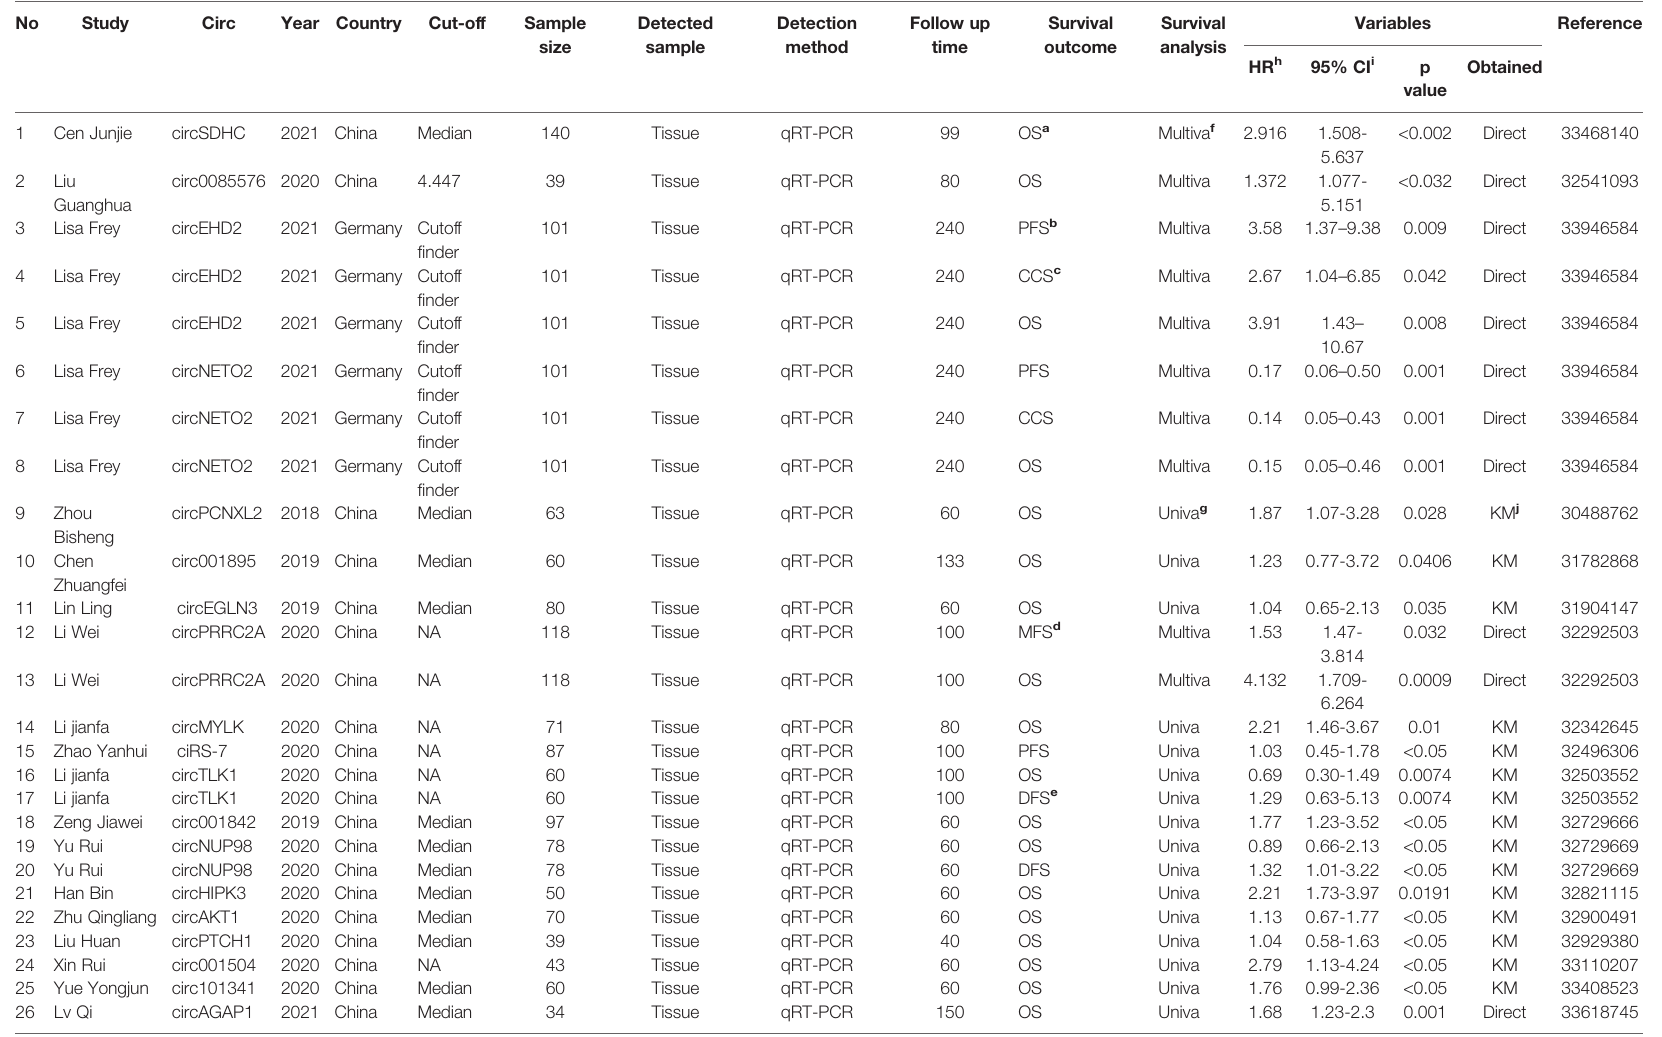
TABLE 1 | Main characteristics of studies related to prognosis included in the